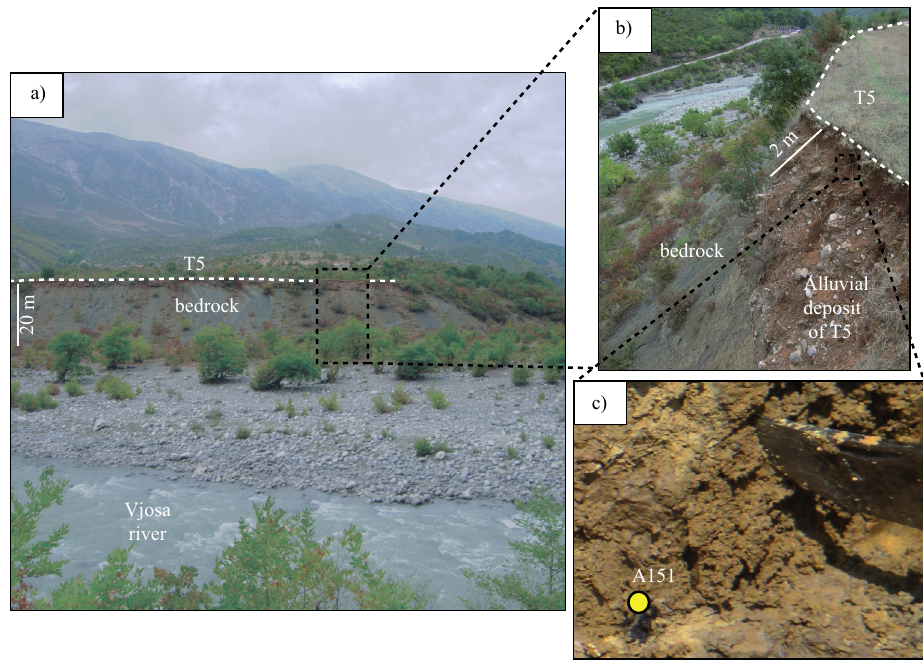
Figure 7. Example of a thin strath terrace above the Vjosa river. (a) General view: the top of the terrace is 22 m above the low flow of the river. (b) View of the alluvial deposit located above the strath surface. The deposit is around 2 m thick. It is constituted by gravels and peb- bles embedded in a clay and silt matrix. Radiocarbon sample was taken close to the top of the terrace. (c) View of a sampled organic mate- rial (sample A151, in Table 1) that gives an age of abandonment of 29.35 ± 0.89 cal ka BP ka for this terrace (terrace